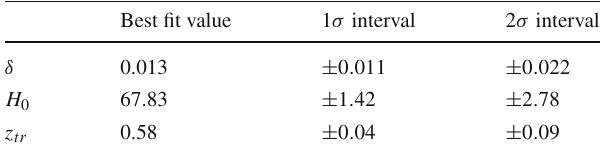
Table 3 Best fit values of the model parameters δ , H 0 and z tr together with their 1 σ and 2 σ confidence intervals for the exponential